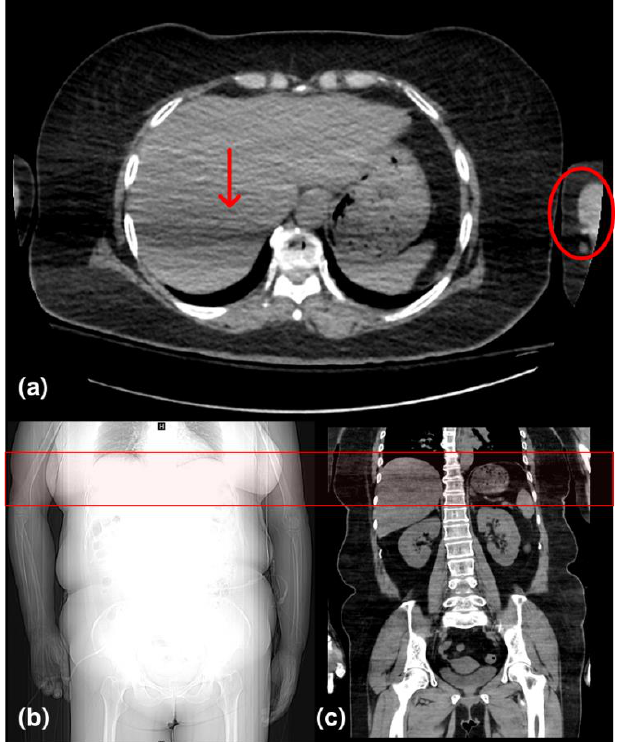
Figure 4. Abdominal CT images with an artifact (red arrow) due to overlap of the liver region with the distal humerus (red circle). This region has the greatest total effective thickness because of the arm (red box). ( a ) Axial image, ( b ) scout image, and ( c ) coronal image of a group A patient (M, 54 years, BMI: 31.87 kg/m 2 ) with arms-down position. Values of CTDI and DLP were 9.60 mGy and 545.37 mGy · cm, respectively.